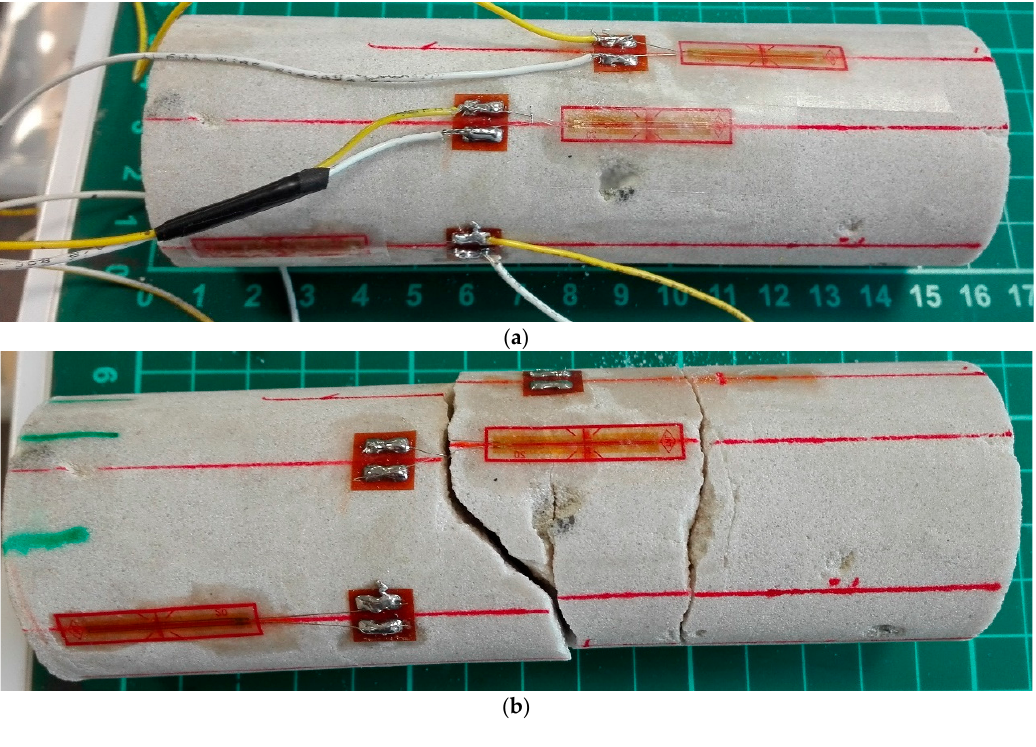
Figure 2. Spalling sample ( a ) prior to testing and ( b ) after testing.